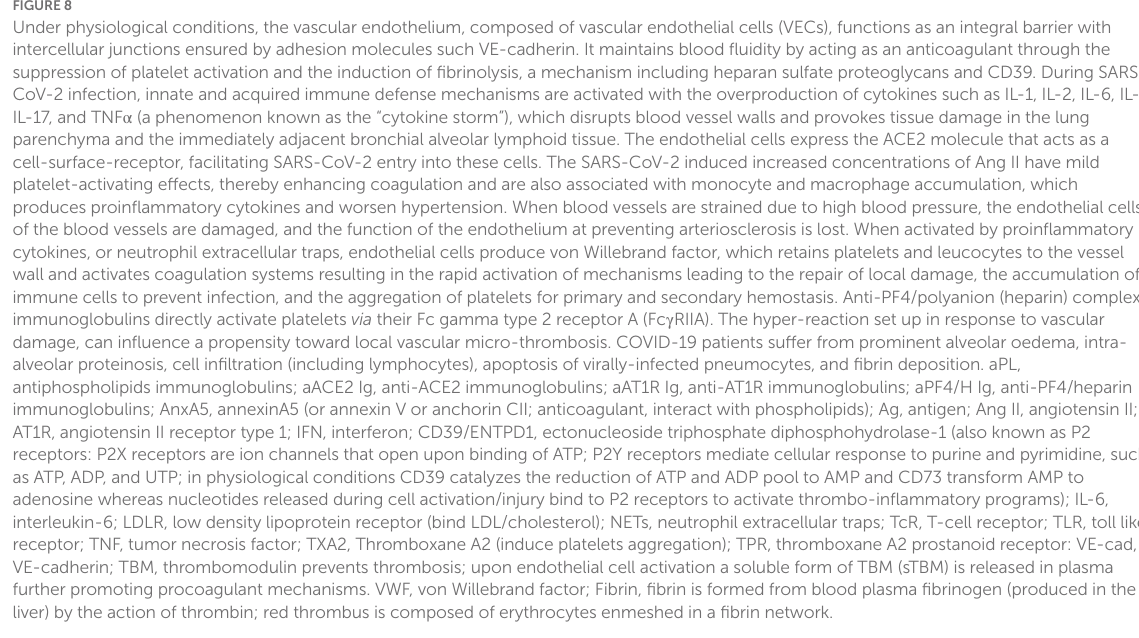
SARS-CoV-2 main protease M pro causes microvascular brain pathology by cleaving NEMO (an essential modulator of NF-κB) in infected brain ECs (Wenzel et al., 2021).